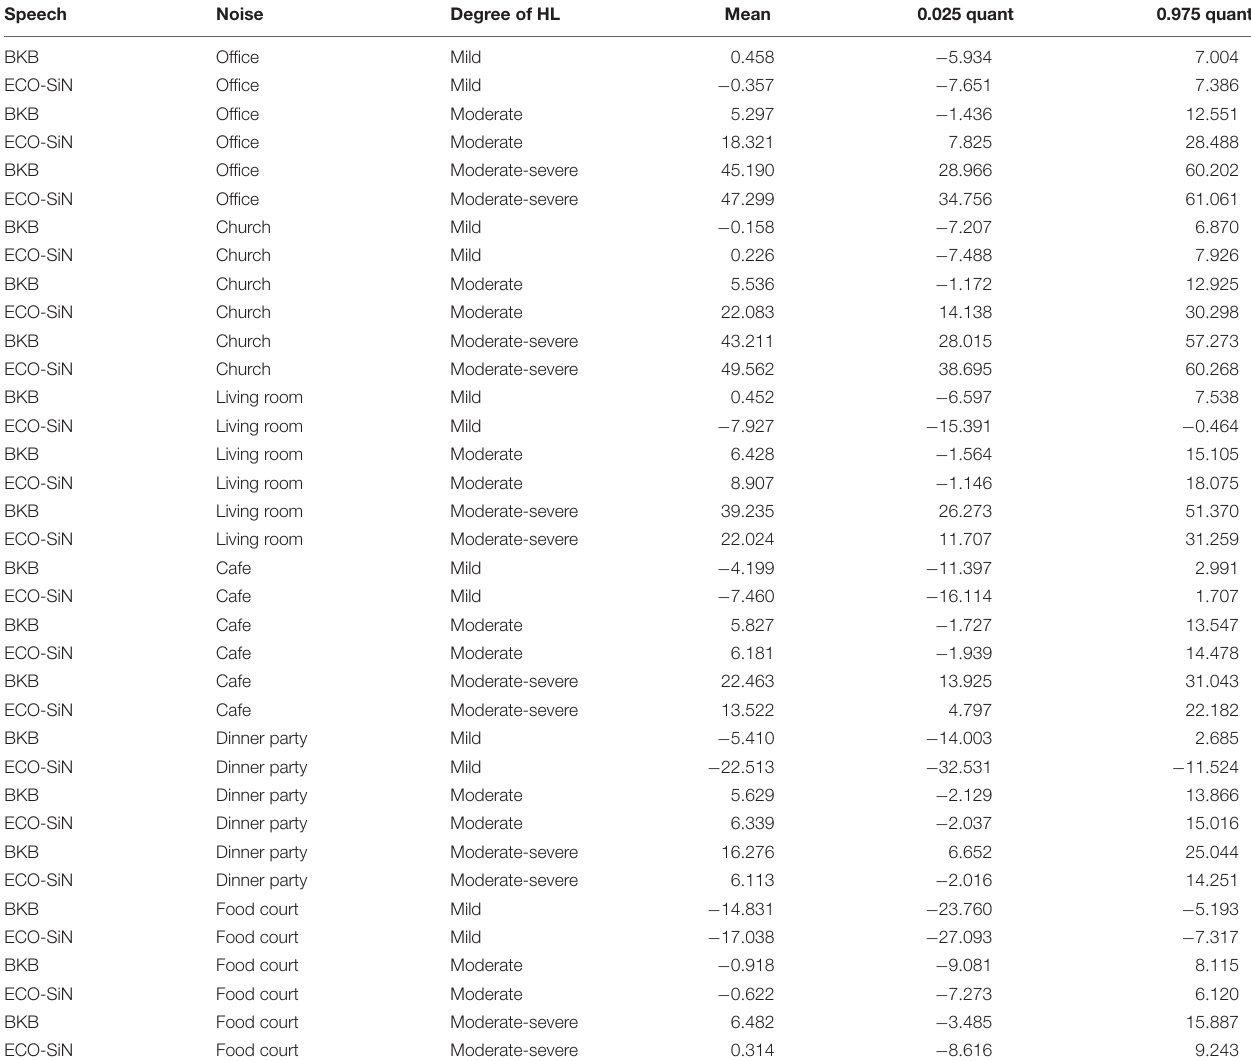
TABLE 4 | Results of the statistical analysis of the hearing-aid